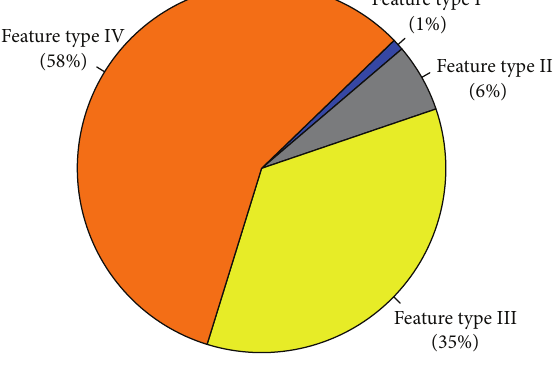
Figure 4: Pie distribution for four subpools of prognostic predictors from the networks of NR5A2 and NR5A1 . (a, b) Pie distribution for four subpools of classified prognostic predictors derived from the networks of NR5A2 in two selected populations. Two cohort relevant networks of NR5A2 (91A cohort and 181A cohort) identify 131 probes and 302 probes to be the potential prognostic factors in the 91A and 181A cohort, respectively. The pie distribution illustrates four classified prognostic predictor subpools derived from overlapping between the cohort relevant network of NR5A2 and four types of prognostic indicators in three selected populations (91A cohort, 90A cohort, and 181A cohort). (a) The four feature types follow an order of type IV > type II > type III > type I. (b) Four feature types follow an order of type IV > type III > type II > type I. (c) Four subpools of classified prognostic predictors derived from the networks of NR5A1 in 181A cohort; the 181A cohort relevant network of NR5A1 predicts 1,334 probes to be the potential prognostic factors in 181A cohort. The feature type distribution follows an order of type IV > type III > type II > type